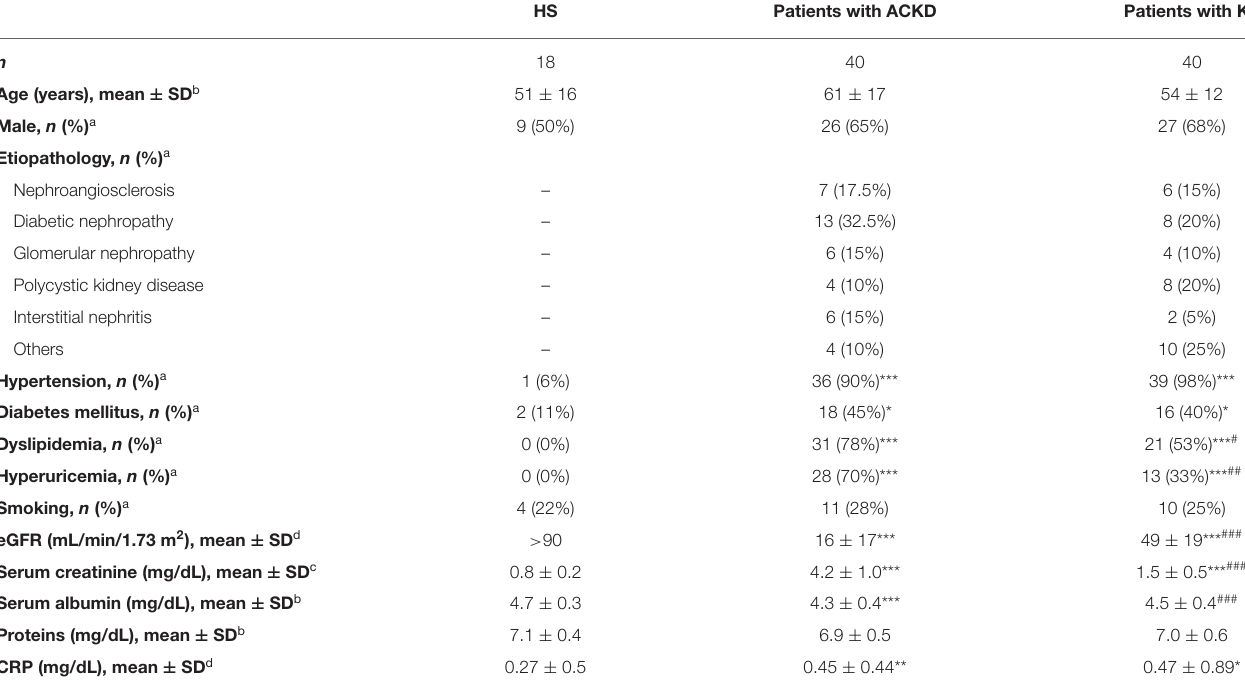
HS Patients with